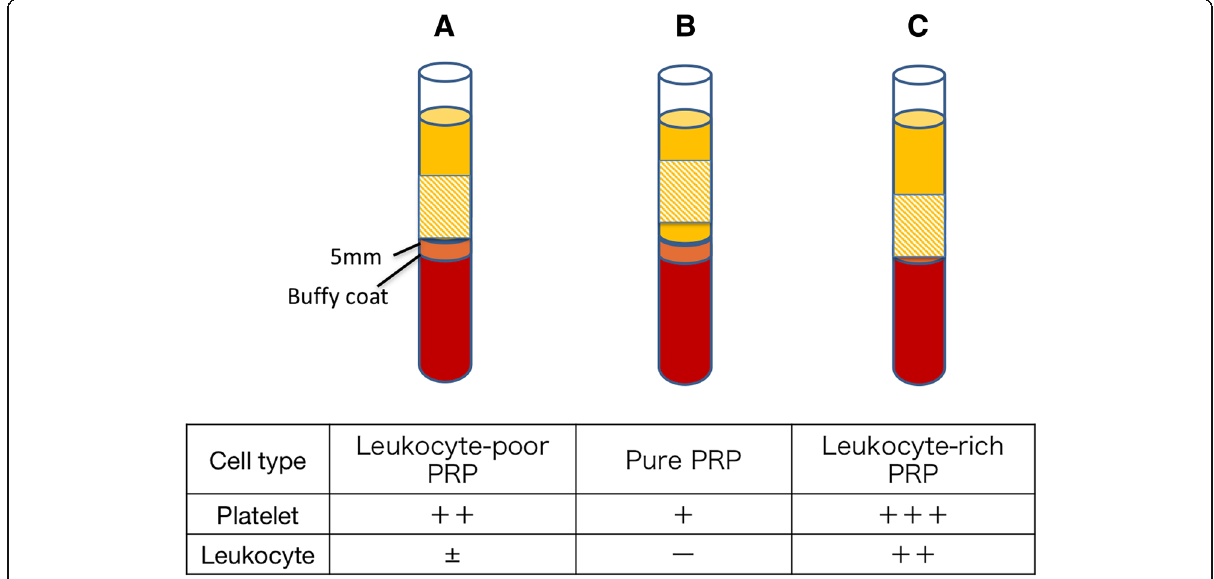
Fig. 6 Scheme of the the centrifuged blood with PRGF-Endoret protocol. A line was drawn 5 mm above the buffy-coat layer in the separated blood, and the layer above this line was divided into two. The upper portion was designated as PPP, and the lower portion was designated as PRP. a The target layer (shaded area) of the PRP system, containing LP-PRP. b When aspirating from above the target layer (shaded area), the platelet concentration obtained was relatively low, without contaminating leukocytes, representing purified PRP. c Aspirating from layers below the target layer (shaded area), platelet concentration increased, though leukocytes were retained, which was leukocyte-rich